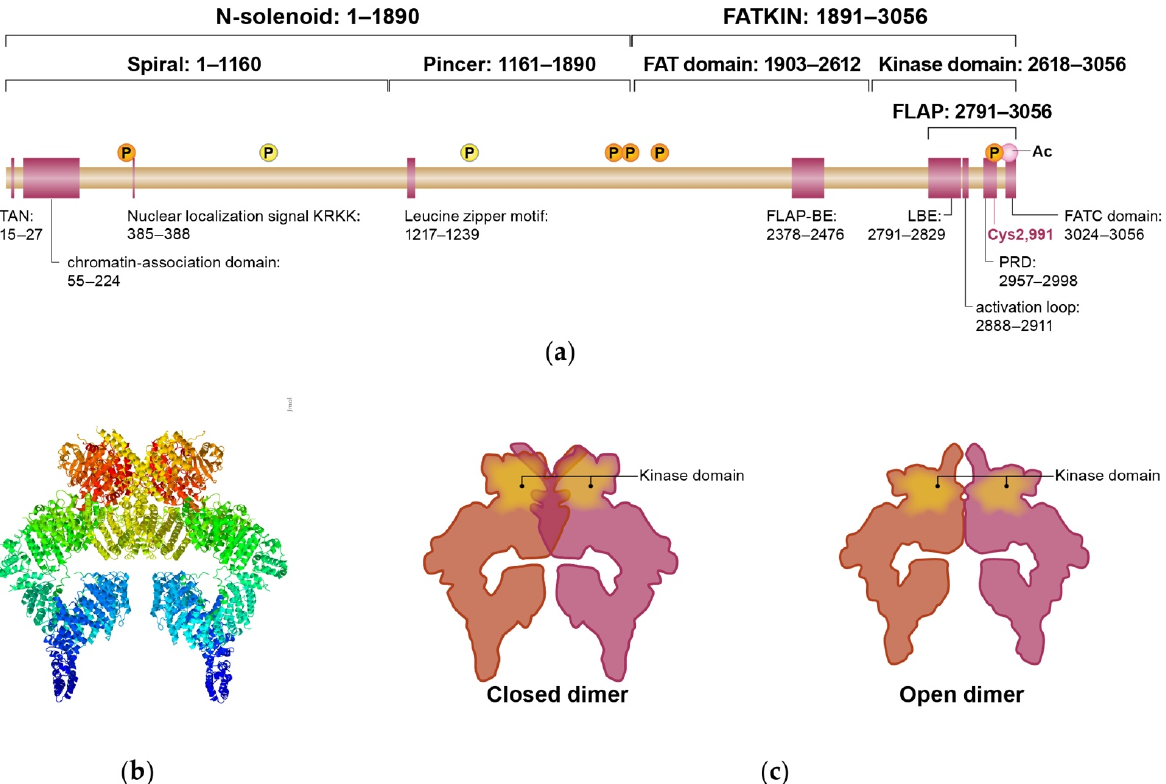
Figure 1. ( a ) Map of the ATM protein, consisting of 3056 amino acids. ATM domains and motifs are listed with their amino acid numbers. Chromatin-association domain serves is important in interacting with chromatin or partner proteins. Nuclear Localization Signal enables nuclear translocation of ATM. Lys3016 is acetylated by TIP60. ATM has multiple phosphorylation sites that can substantially affect its kinase function. Ser367, Ser1893, Thr1885, Ser1981, and Ser2996 are auto-phosphorylated sites. Among them, auto-phosphorylation on Ser367, Ser1893, Ser1981, and acetylation on Lys 3016 are important for ATM activation. FATC domain on C-terminus of ATM is essential for its full activation. Cys2991 is essential to form disulfide bond between two ATM monomers. ( b ) The structure of an ATM closed dimer (PDB ID: 6K9L [23]), created with Jmol, an open-source Java viewer for chemical structures in 3D. ( c ) A schematic representation of the ATM protein. Interface of ATM homodimer consists of upper (FLAP − FLAP-BE) and lower (M-FAT − M-FAT) layers. In the closed dimer, active site of kinase domain is blocked, leaving ATM in an inactive state. In the open dimer, the upper interface is lost, resulting in more compact dimer and allowing partial access to the active site of the kinase domain. FAT-KIN: FAT-phosphatidylinositol 3-kinase-like kinase domain; FLAP-BE: FLAP-binding element; FLAP: Lst8 binding element (LBE), activation loop, and PIKK-regulatory domain (PRD) region .